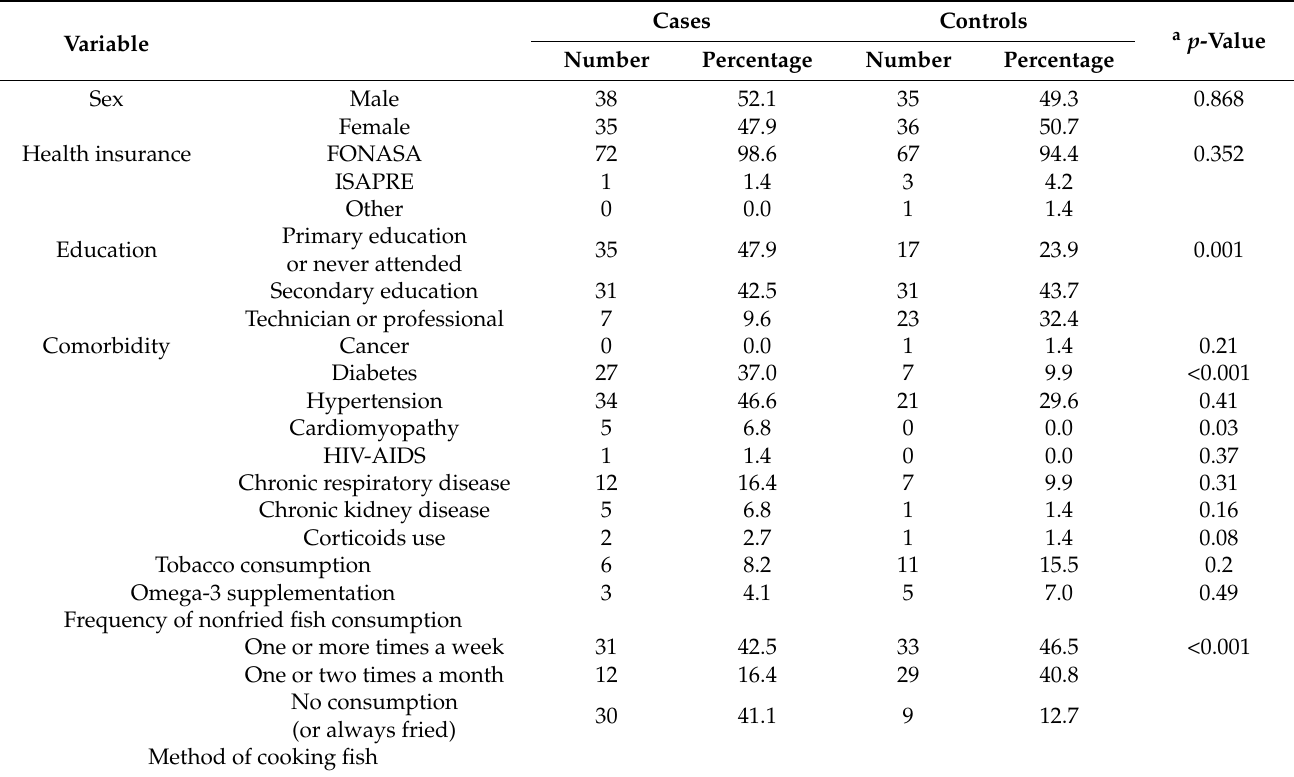
Table 1. Characteristics of case and control